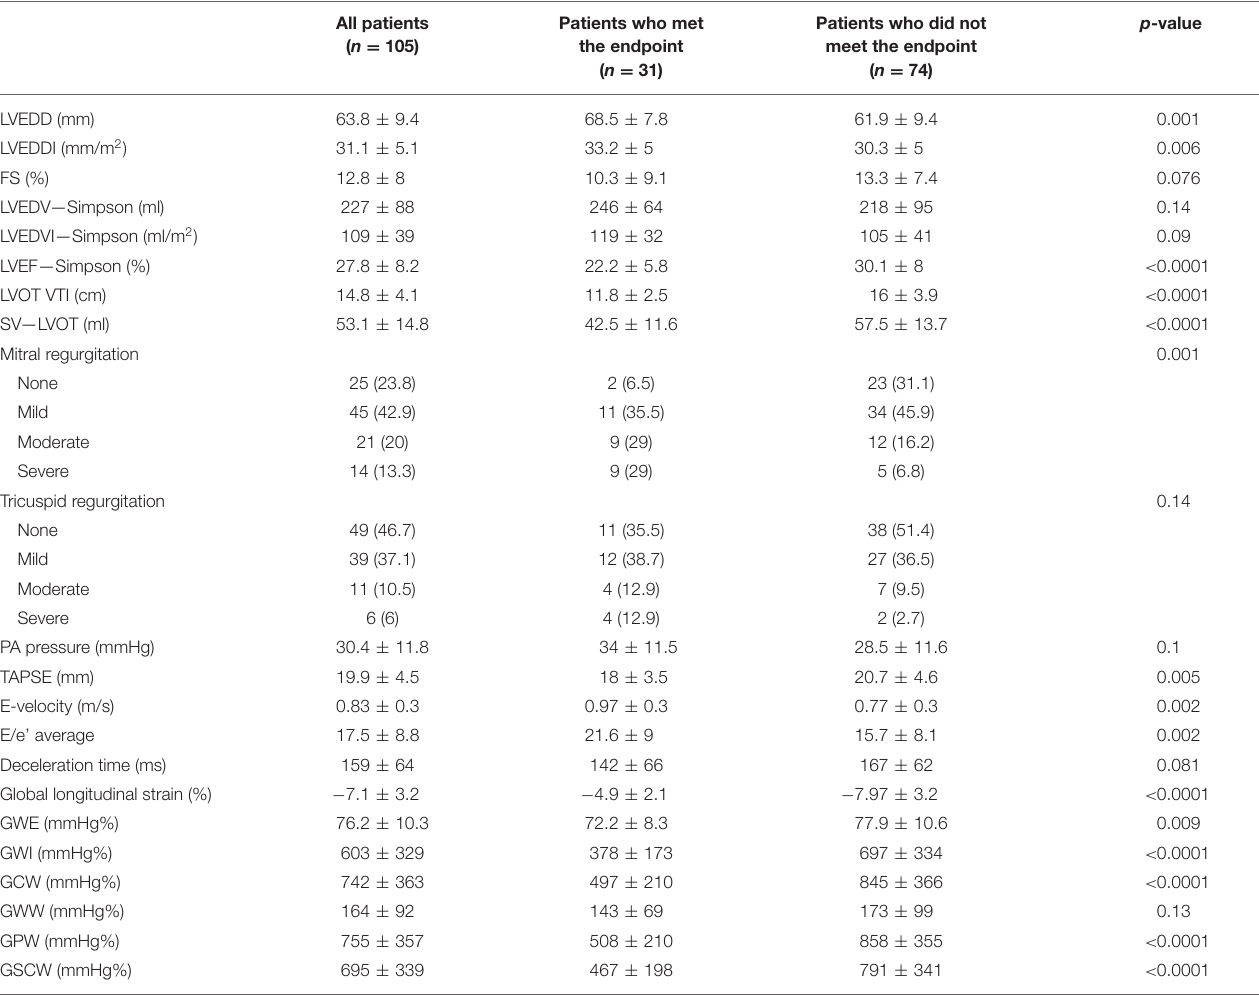
TABLE 2 | Echocardiographic characteristics of all patients.